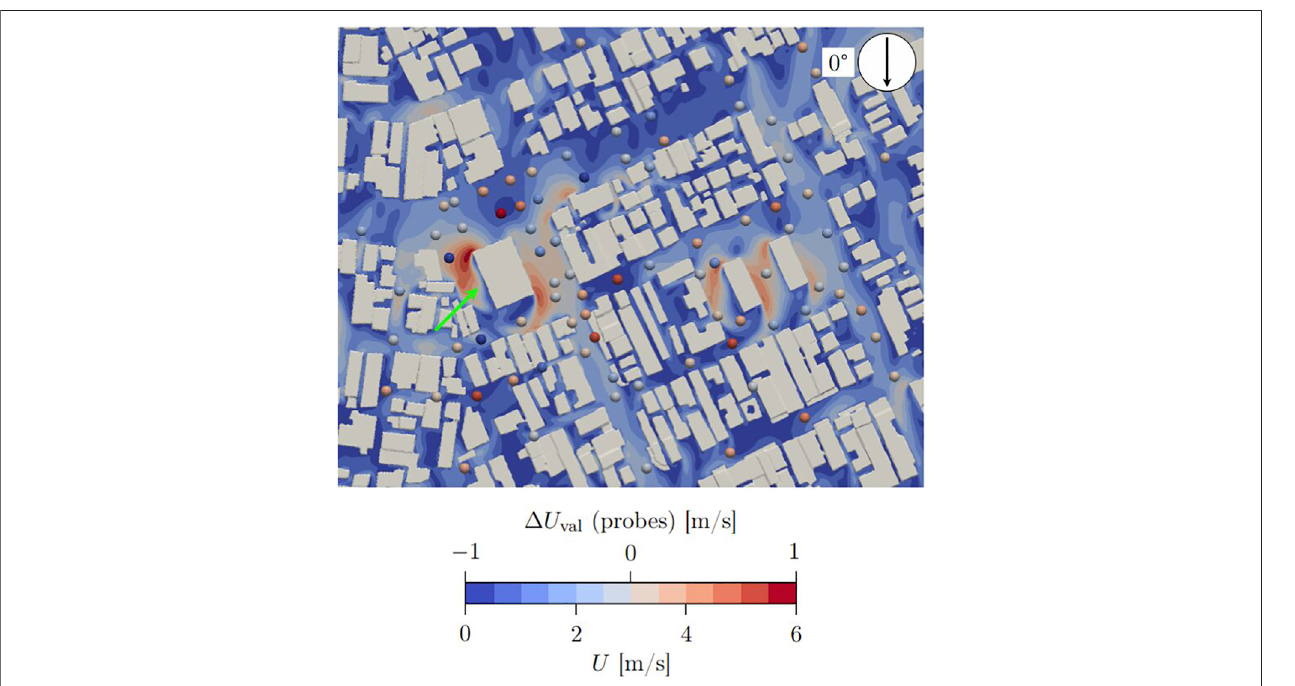
FIGURE 4 | Normalized simulated wind speed at 2 m above ground with wind from N (0 ° ). The colored dots represent the wind speed difference, Δ U val , between the wind tunnel experiment and the simulation at the 80 probes. The black arrow indicates the wind direction at the inlet, and the green arrow points to the high-rise building.